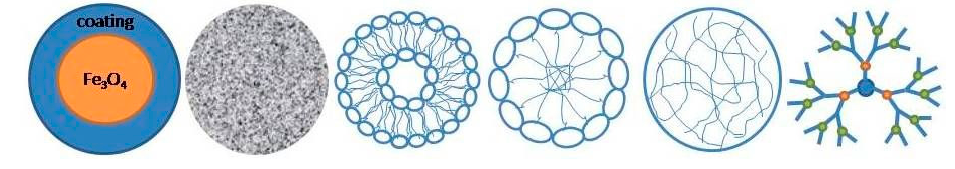
Figure 4. Typical nanocarriers: (from left) superparamagnetic iron-oxide nanoparticles, silica-based nanoparticles, liposomes, micelles, polymeric nanoparticles, and dendrimers.